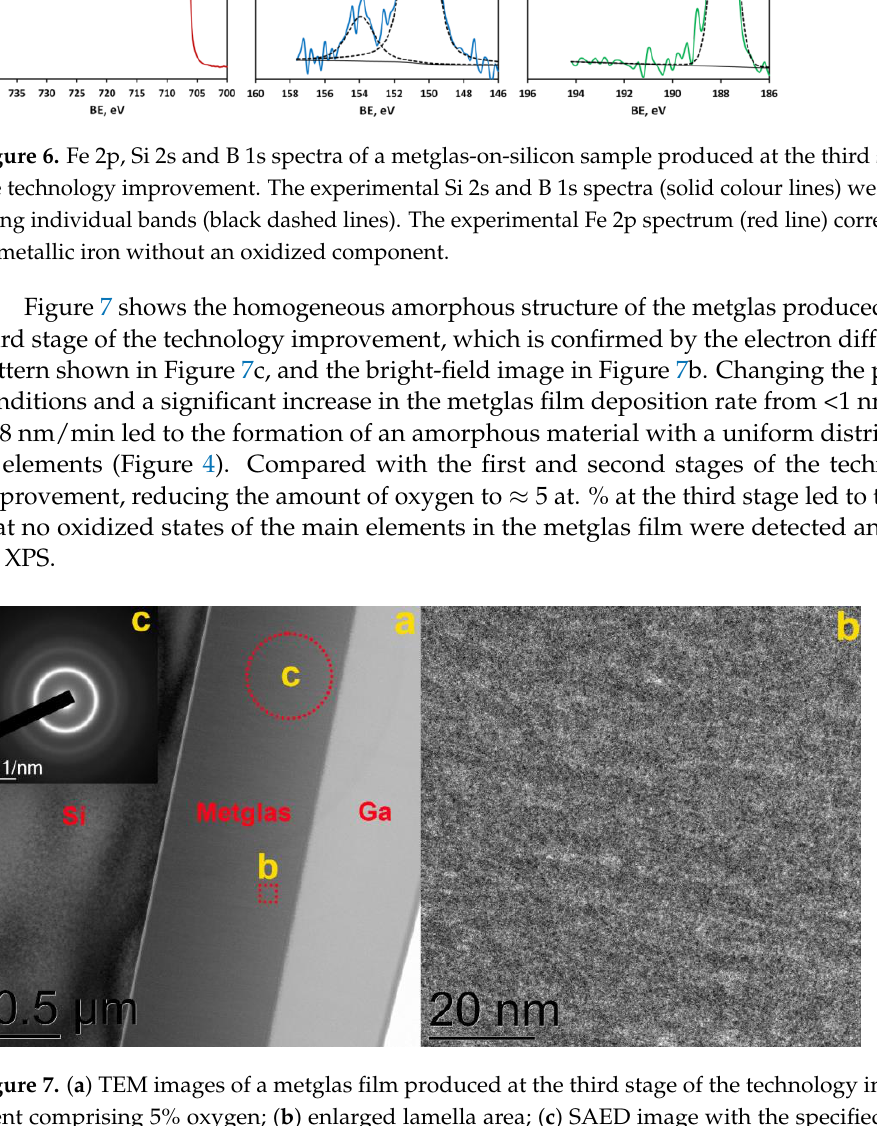
( b ) Figure 8. ( a ) Photo of the top and bottom view of the ME MEMS sample and schematic layer struc- ture, where the arrows indicate spontaneous polarization vectors in the head-to-head bidomain LN crystal. ( b ) Dynamic direct ME coefficient |α 32 | measured as a function of the frequency of AC mag- netic field with an amplitude of 0.1 Oe and the optimal bias field H = 6 Oe. The inset shows the quasi-static in- plane direct ME coefficient |α 32 | measured as a function of the DC magnetic field.